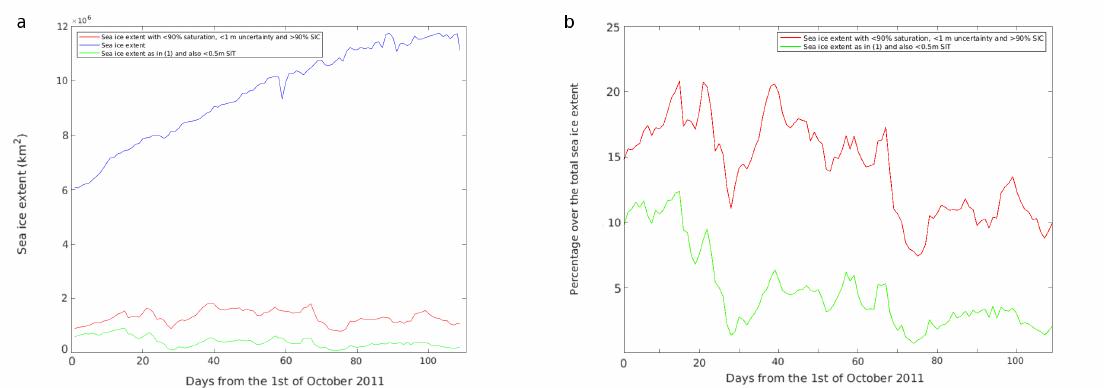
Figure 9. ( a ) Sea ice extent during the freeze-up period of 2011. The blue line depicts the full sea ice extent. The red line for ice that has <90% saturation, <1 m uncertainty and >90% SIC. The green line represents the same conditions as the red line but only for SIT below 0.5 m. ( b ) Same red and green lines as in ( a ) but shown as percentage of the total (blue